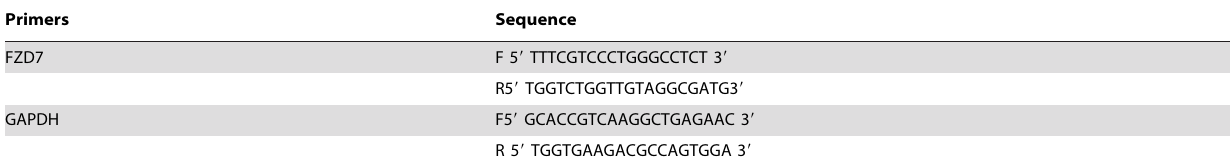
Primers Sequence